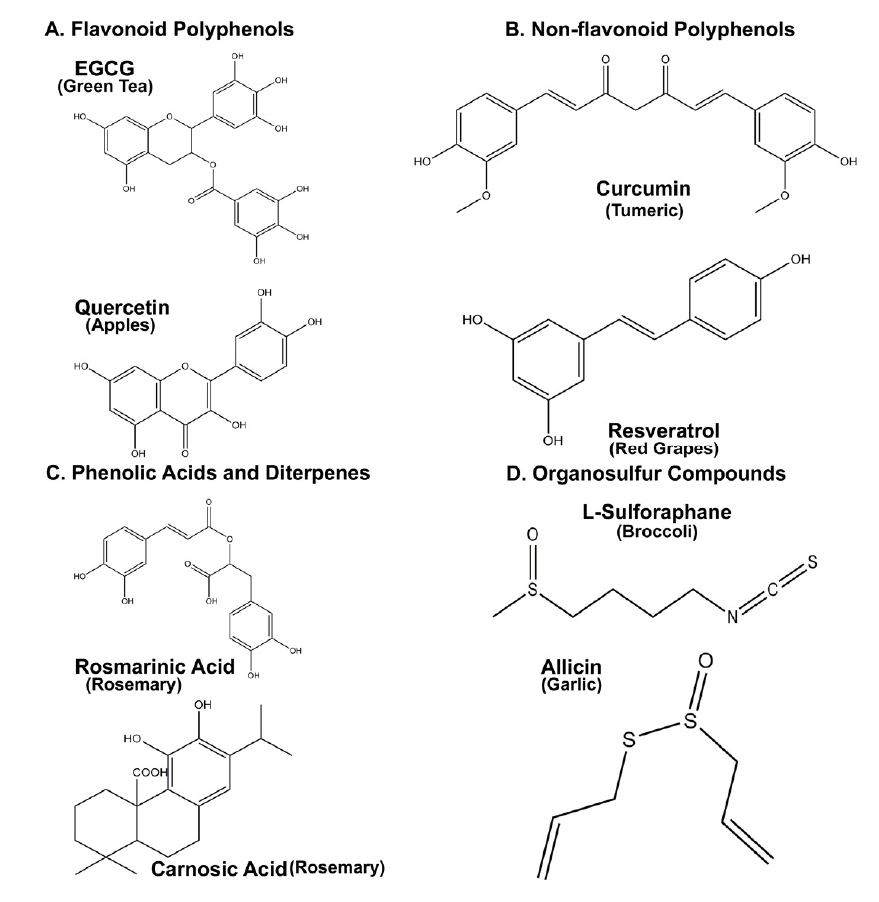
Figure 1. Chemical structures of various nutraceutical